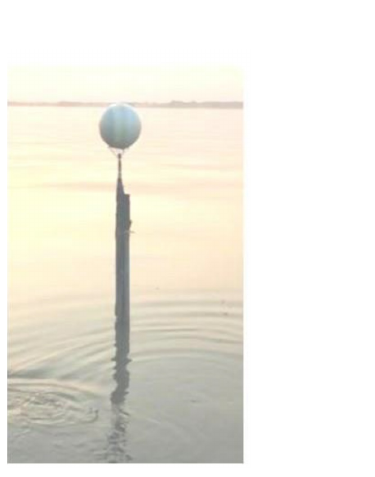
Fig. 3 The installation scheme of the Luneburg lens